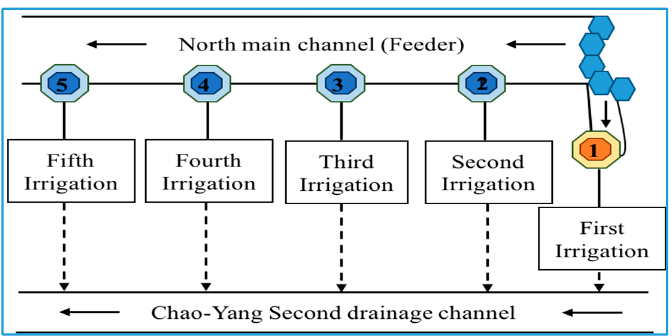
Figure 8. Direction and sequence of the drainage and irrigation in the study region.